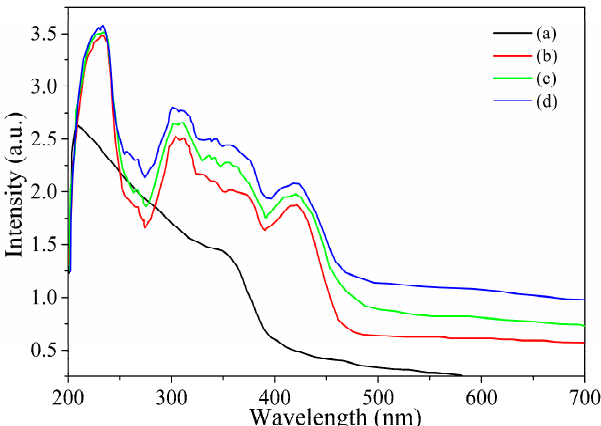
Figure 5. UV-vis absorption of TiO 2 nanospheres before ( a ) and after modifying Aphen with Aphen/ TiO 2 ratio of 1:50 ( b ); 1:100 ( c ) and 1:200 ( d ).